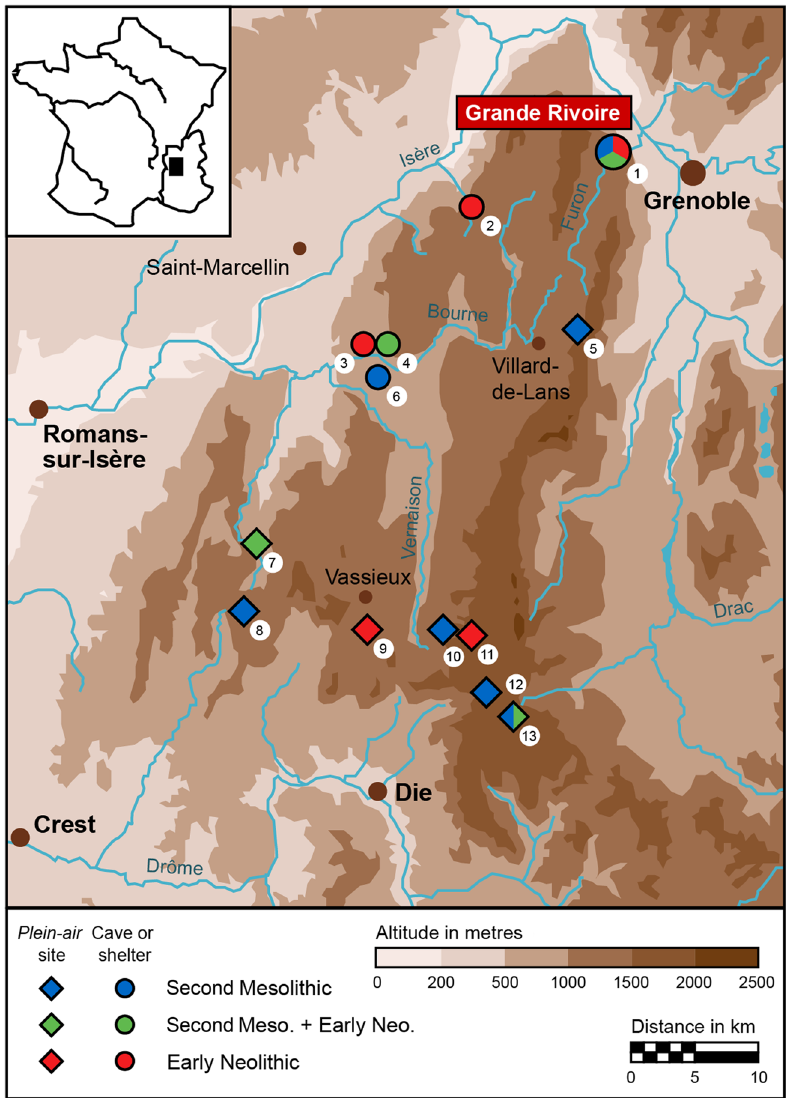
Figure 4: Geographical location of sites in the Vercors massif that has yielded material with components from the Second Mesolithic to the Early Neolithic ( modi fi ed from Nicod et al., 2012 ) . 1: Grande Rivoire; 2: Pas de l ’ Échelle; 3: Balme Rousse;